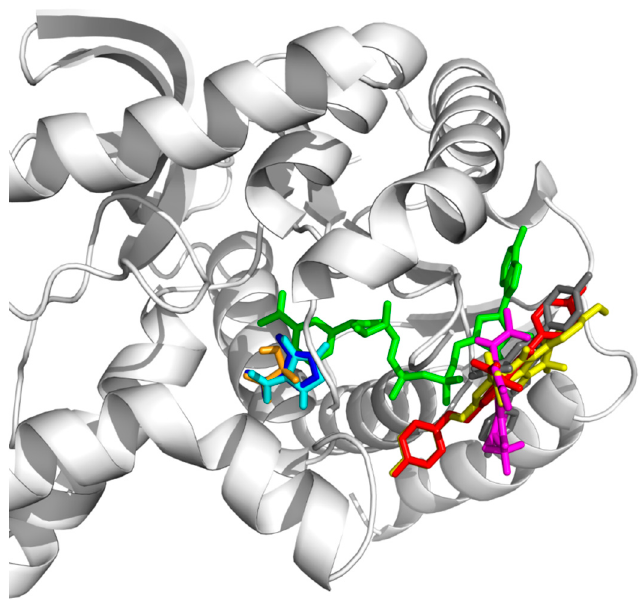
Figure 3. The conformation of OXQ crystal structure (dark blue stick presentation), docked OXQ (light blue stick presentation), lactate (brown stick presentation) and test compound 3a , 3f , 4a and 4g (grey, red, pink and yellow stick presentation, respectively) in parasite lactase dehydrogenase (pLDH). Green stick is the NAD+ as the co-factor of pLDH.